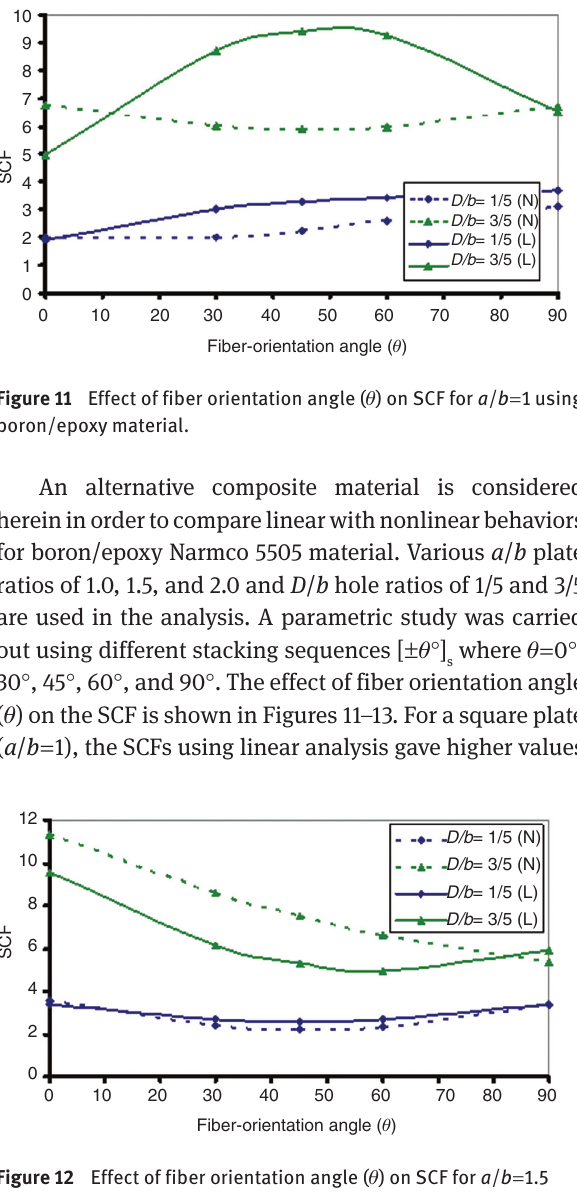
Figure 12 Effect of fiber orientation angle ( θ ) on SCF for a / b = 1.5 using boron/epoxy material.